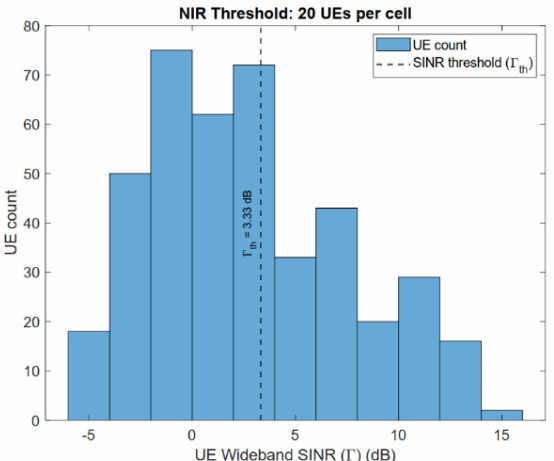
Figure 3. Wideband SINR distribution for 20 UEs.